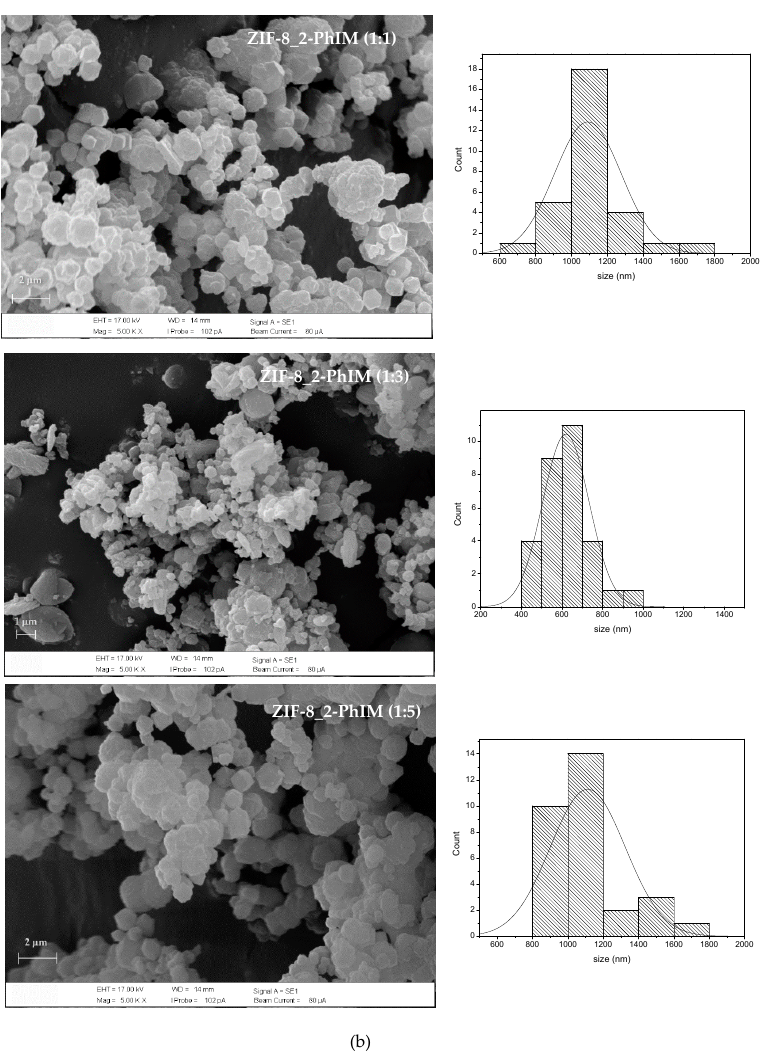
Figure 10. (a) Exchanged ZIF-8 samples for 2-NH 2 bZIM linker at various ratio between ZIF-8 and 2-NH 2 bZIM. (b) Exchanged ZIF-8 samples for 2-PhIM linker at various ratio between ZIF-8 and 2-PhIM.